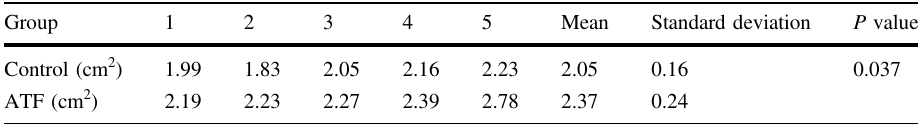
Table 1 Measurement data of the two groups of the paraspinal muscle on the cross-section